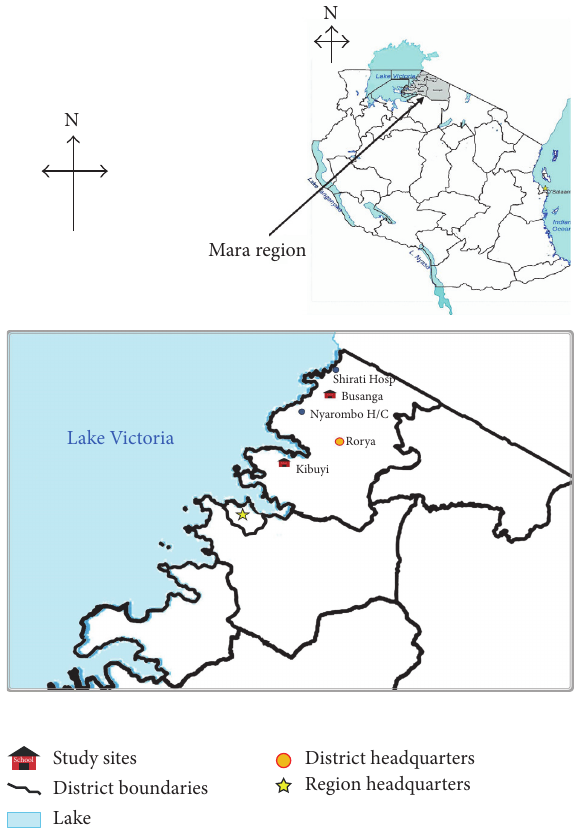
Figure 1: The study sites in Rorya District,